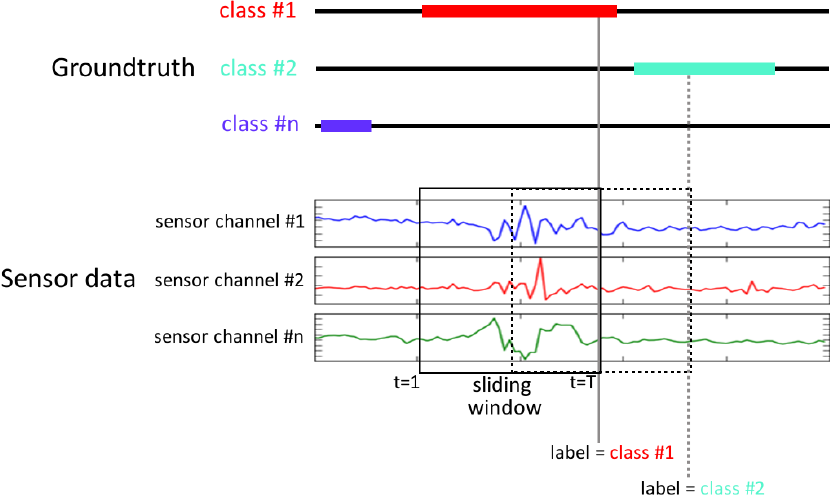
Figure 5. Sequence labelling after segmenting the data with a sliding window. The sensor signals are segmented by a jumping window. The activity class within each sequence is considered to be the ground truth label annotated at the sample T of that